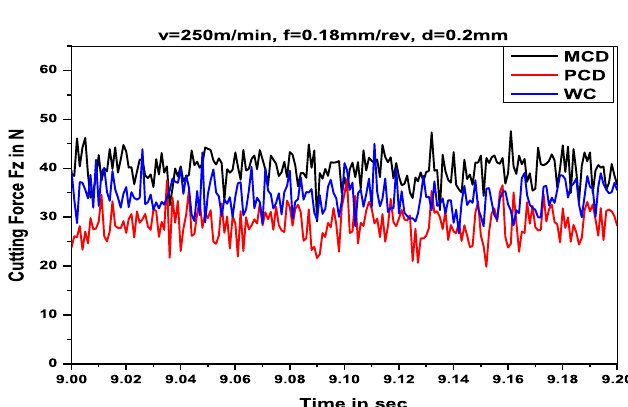
Fig. 10. Dynamic component of cutting force vs. time graph at v = 250m/min, f =0.18 mm/rev, d = 0.2mm.